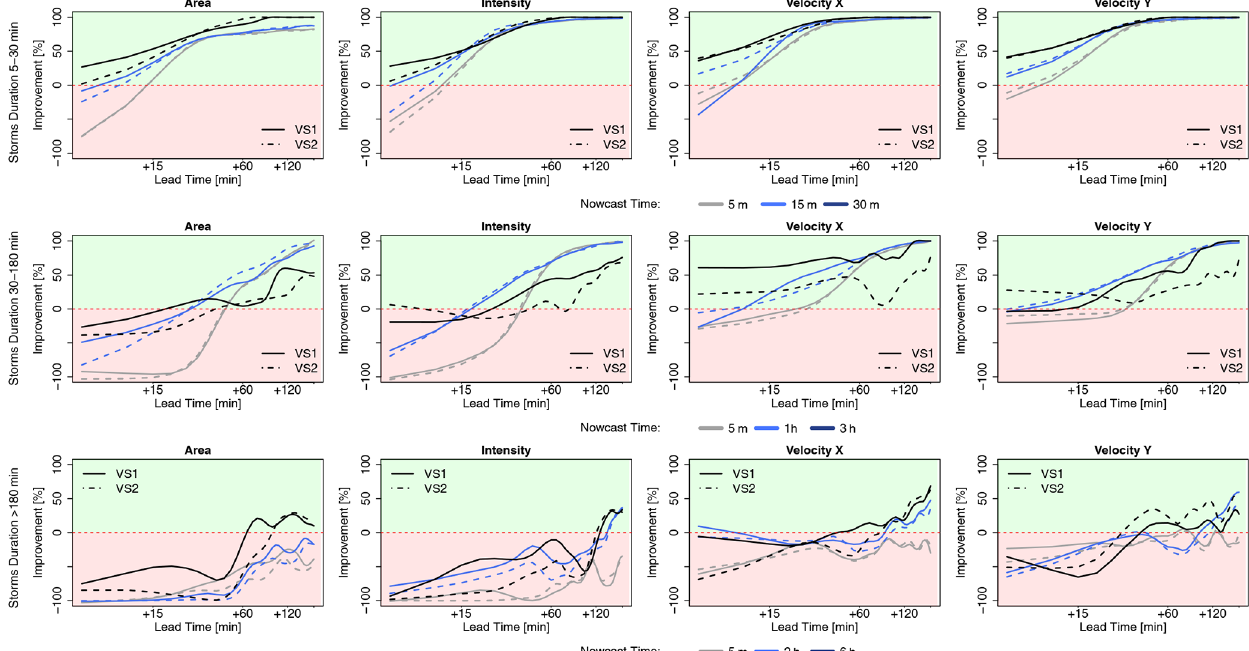
Figure 10. The median improvements over all the events that the single 4-NN application can introduce in the nowcast of the target variables (area, intensity, and velocity in the x and y directions) in comparison to the Lagrangian persistence. The results are shown for each 4-NN application: VS1 in solid and VS2 in dashed lines and calculated separately for storms that last for less than 30min (upper row), less than 3h (middle row), and more than 3h (lower row) and for the respective nowcast times. The green region of the plot indicates a positive improvement (better nowcast by the 4-NN application), and the red region indicates a deterioration (better nowcast by the Lagrangian